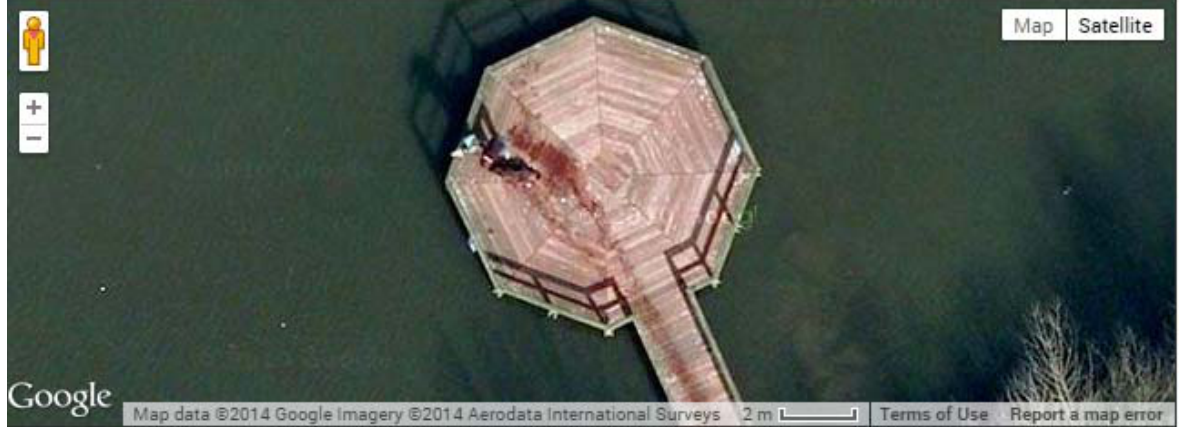
Figure 6. Photo on website titled “Google Sightseeing” featured in an article entitled “Body being dumped into a Dutch canal, caught on Google Maps”. Image from Google Sightseeing Website (unaffiliated with Google)